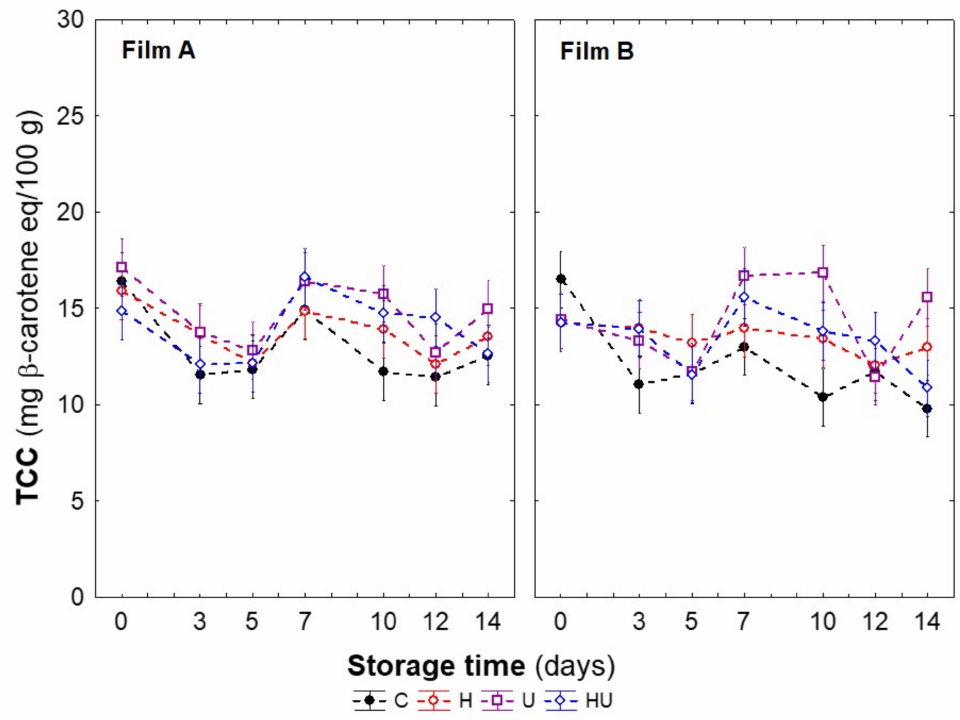
Figure 3. Changes in total carotenoid content (TCC) of fresh-cut carrots as affected by abiotic stress treatments and MAP conditions during low-temperature storage (5 ◦ C, 14 days). Vertical bars denote the confidence interval at